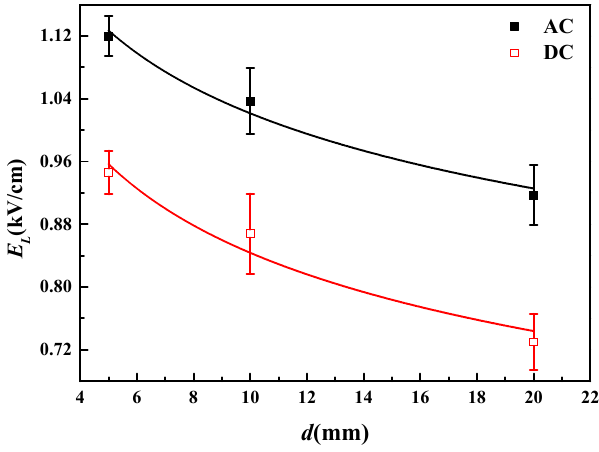
Figure 8. Relationship between E L and d.